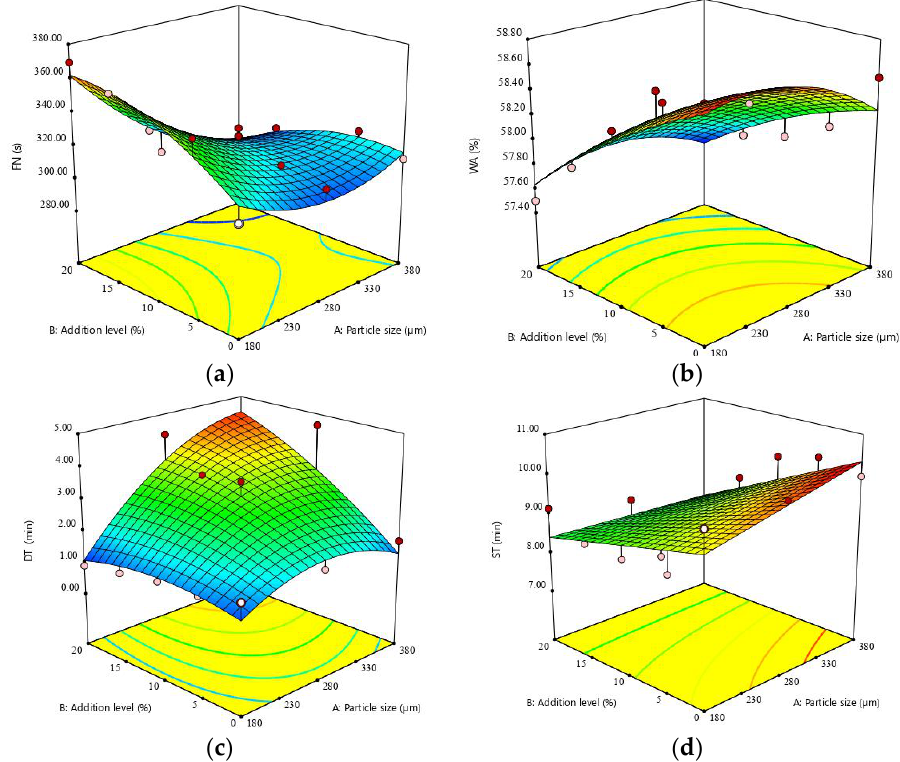
Figure 1. Response surface graphic of ( a ) falling number (FN), ( b ) water absorption (WA), ( c ) devel- opment time (DT), and ( d ) dough stability (ST) as a function of buckwheat flour fraction and addition level.